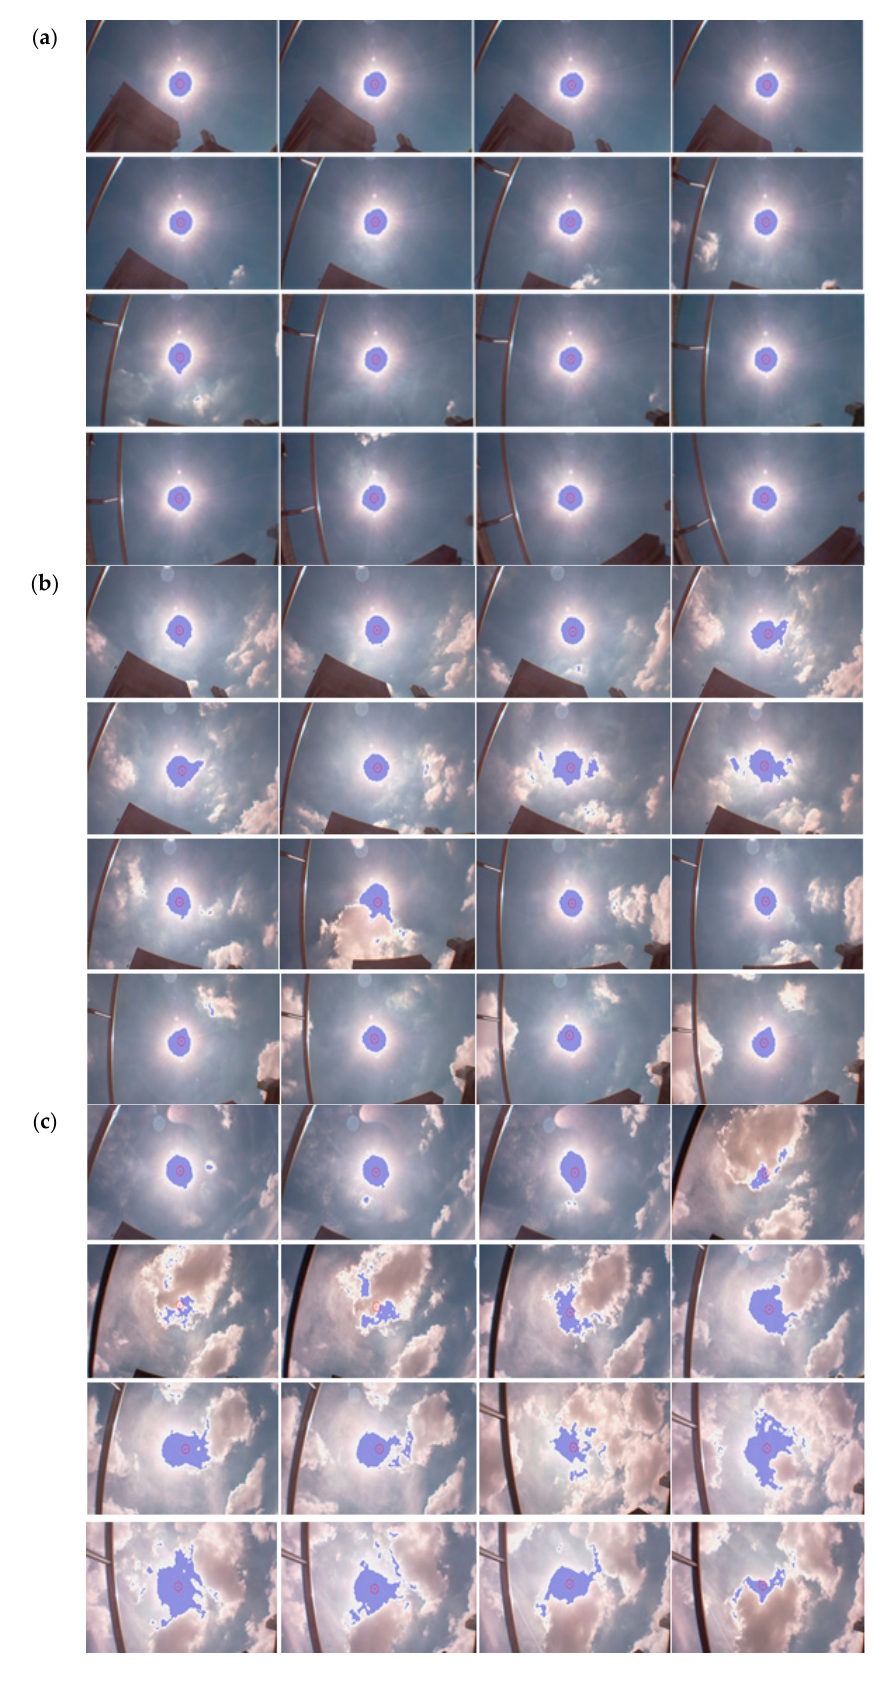
Figure 13. ( a ) The sky is clear, and the real sun center is marked with a red point. The brightest region is marked with blue points; ( b ) The sky is clear most of the time, but there are occasionally some clouds; ( c ) The sky is cloudy most of the time.